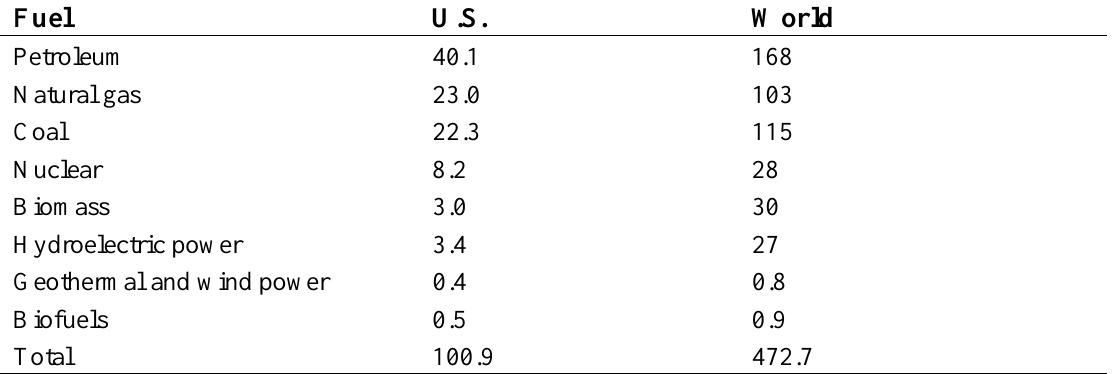
Table 3. Annual fossil and solar energy use in the U.S. and world (quads = 10 15 BTU) [8]. Fuel U.S. World Petroleum 40.1 168 Natural gas 23.0 103 Coal 22.3 115 Nuclear 8.2 Biomass 3.0 Hydroelectric power 3.4 Geothermal and wind